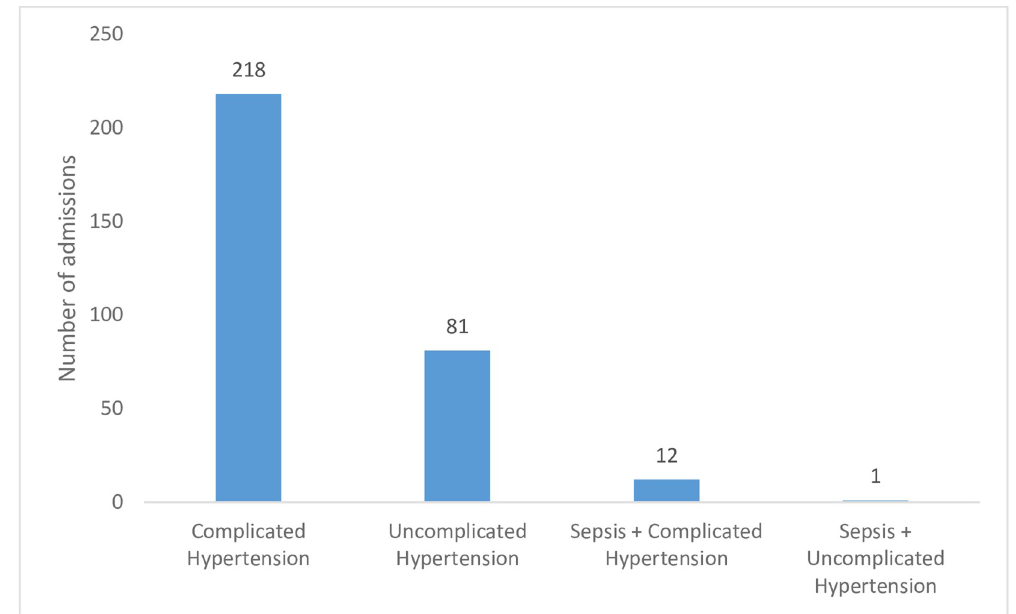
Fig 2. Number of obstetric ICU admissions for various categories of hypertension among participants with hypertension.